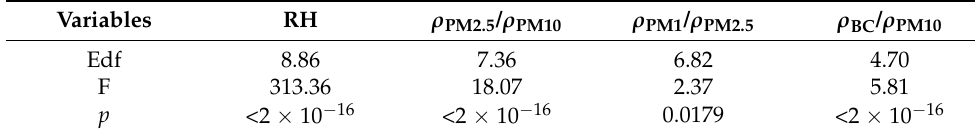
Figure 5. The AIC value of multiple models for the time series of aerosol extinction coefficient per unit of mass (M_multi: model with multi-influencing factors). Table 4. Simulation results by the GAMs with multi-influencing factors.